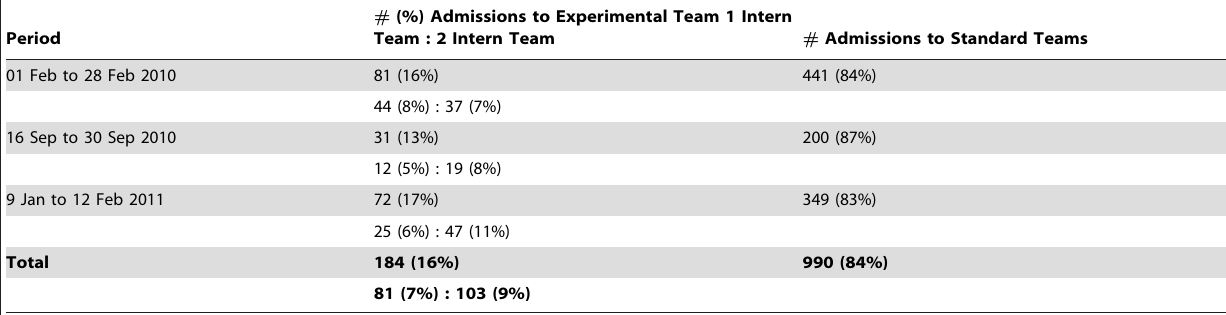
Table 2. Number of Admissions for Experimental and Standard Ward Teams.